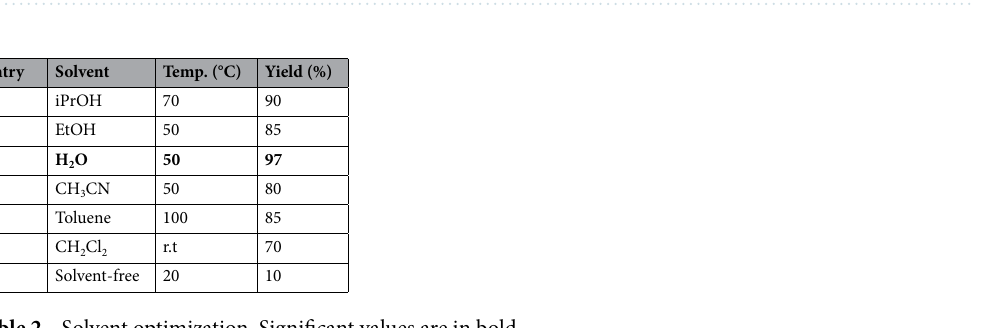
Table 2. Solvent optimization. Significant values are in